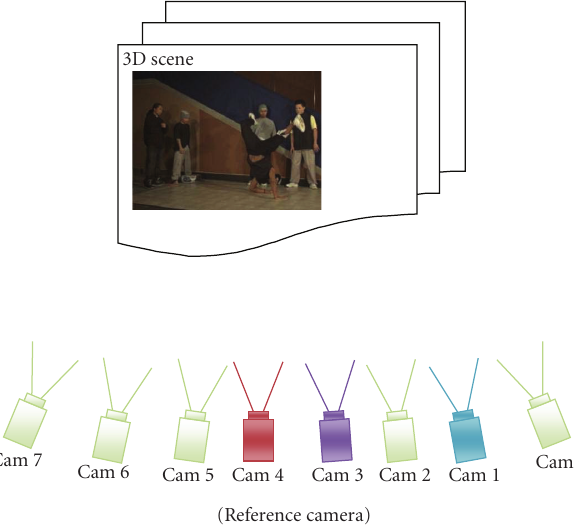
Figure 9: Camera positions for the Breakdance sequence ( Courtesy of Microsoft Research ). The colored cameras correspond to the viewpoints used for the experiments in this paper.